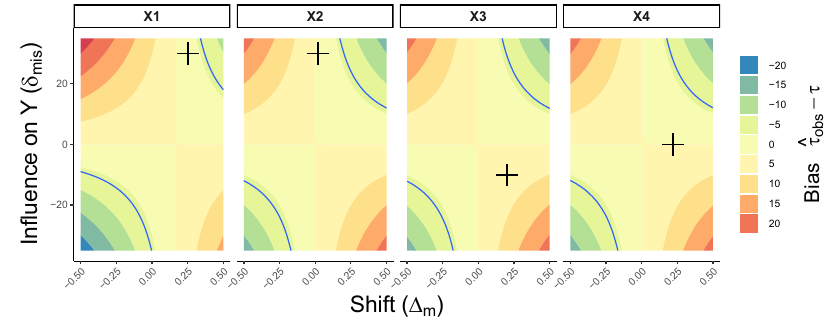
Figure 5: Simulations results when applying procedure 2 : Heatmaps with a blue curve showing how strong an unobserved key covariate would need to be to induce a bias of τ τ − ~ −6 1 in function of the two sensitivity parameters Δ m and δ mis when